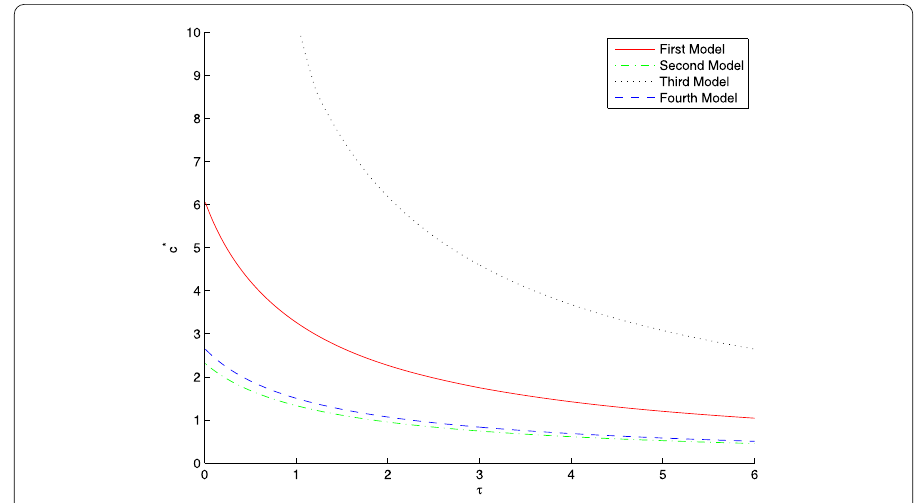
Figure 2 The curves of c ∗ ( τ ). Let F ( S , I ) = β S ∗ I , α = 1, β = 3, S 0 = 1, γ = 1.5, and k = 0.5 be fixed. Additionally, d 2 = 4 and d 3 = 7. We can see that the minimal wave speed c ∗ of the first, second, and third models decreases as τ → ∞